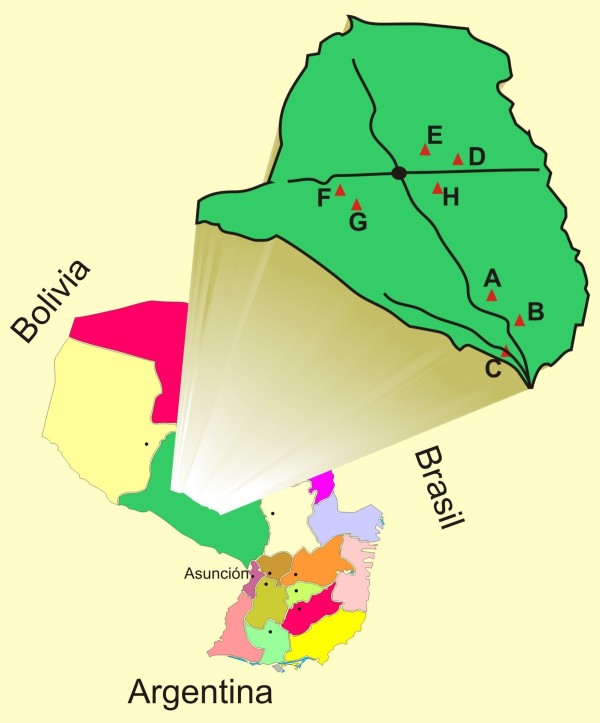
Map of Presidente Hayes Department, Paraguay. Participating communities are marked by triangles; A. Rio Verde (52 km from Asuncion); B. Tobaqom (51 km from Asuncion); C. Quemkuket (30 km from Asuncion); D. Maxhawaya (326 km from Asuncion); E. Laguna Pato Complex (320 Km from Asuncion); FyG. Novoctas (434 km from Asuncion) and H. Espinillo (297 km from Asuncion).